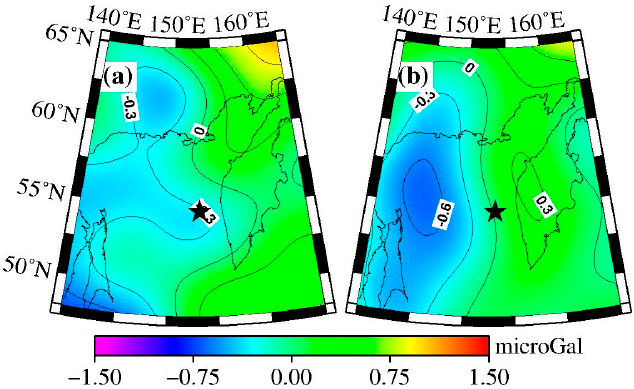
Figure 5. Spatial patterns of the differences between the observed results and the modeled ones: ( a ) between the difference-method results and the modeled results; and ( b ) between the LSF results and the modeled results.